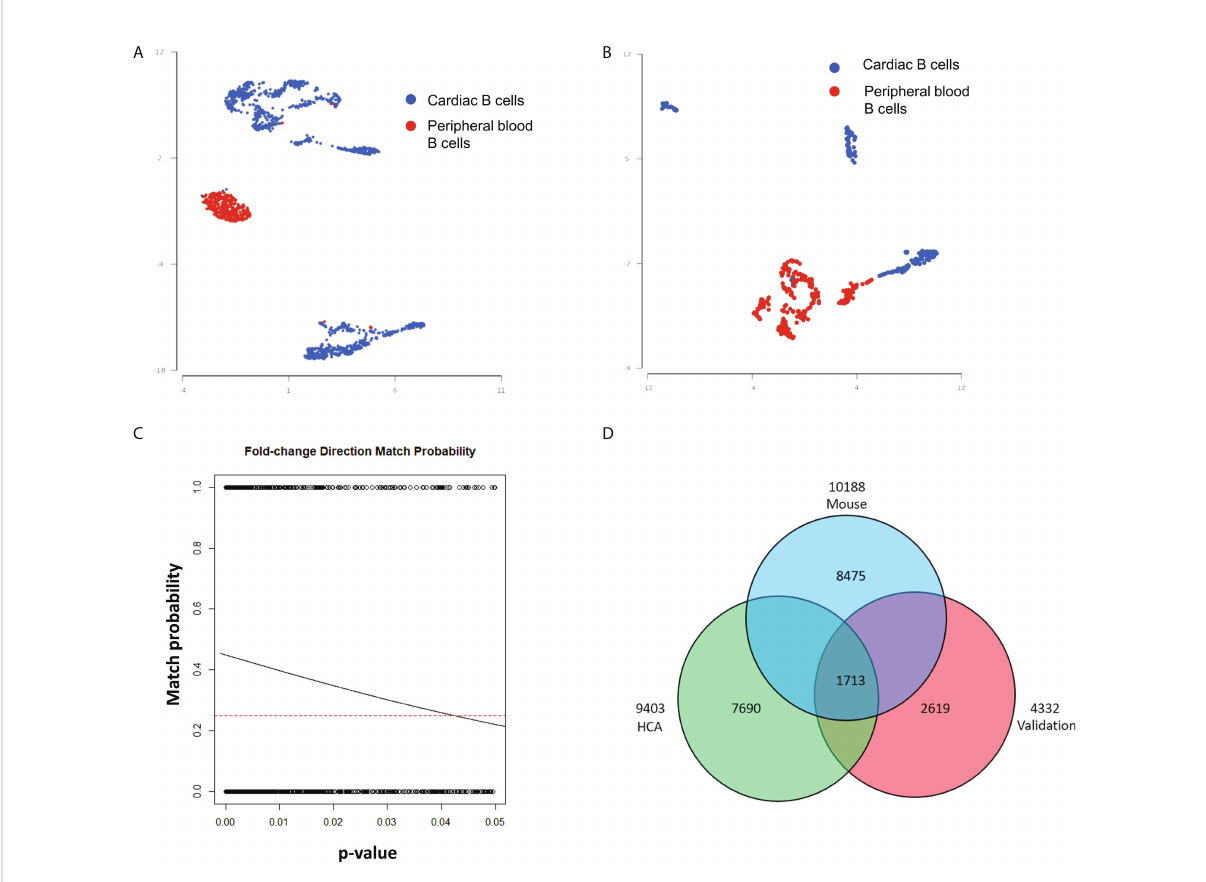
FIGURE 3 Differential gene expression analysis of myocardial and peripheral blood B-cells reveals characteristics of myocardial B-cells conserved across species. (A) UMAP plot of single-cell gene expression of myocardial B-cells from the human Heart Cell Atlas (blue) and 20k peripheral blood mononuclear cells from 10X Genomics (red). Data were merged using Partek Flow. Cells from both sources show important differences in gene expression, however, a small number of peripheral blood B-cells share characteristics with cardiac B-cells and vice versa. (B) UMAP plot of single-cell gene expression of myocardial and peripheral blood B-cells collected from the same patients and analyzed within the same gene expression library using Hashtag antibodies. Also, in this “ validation ” sample myocardial and peripheral blood B-cells have distinct